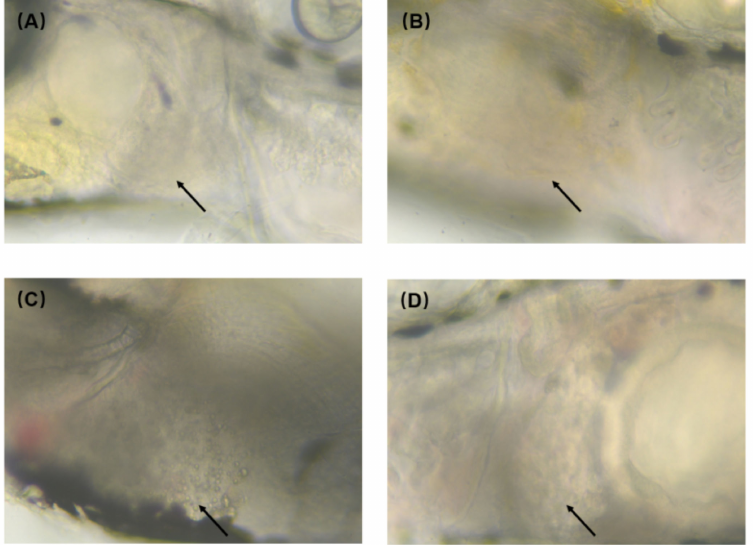
Figure 7. Alleviation of 125 nmol/mL Nano-ZnO toxicity by CDs: ( A ) control group, ( B ) CDs group, ( C ) Nano-ZnO group, ( D ) CDs + Nano-ZnO group. The arrow sites are zebrafish liver. ( A , B , D ) are normal zebrafish liver. ( C ) has obvious lipid